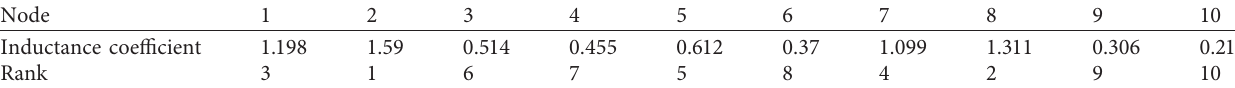
Table 3: Inductance coefficient of nodes in experimental traffic